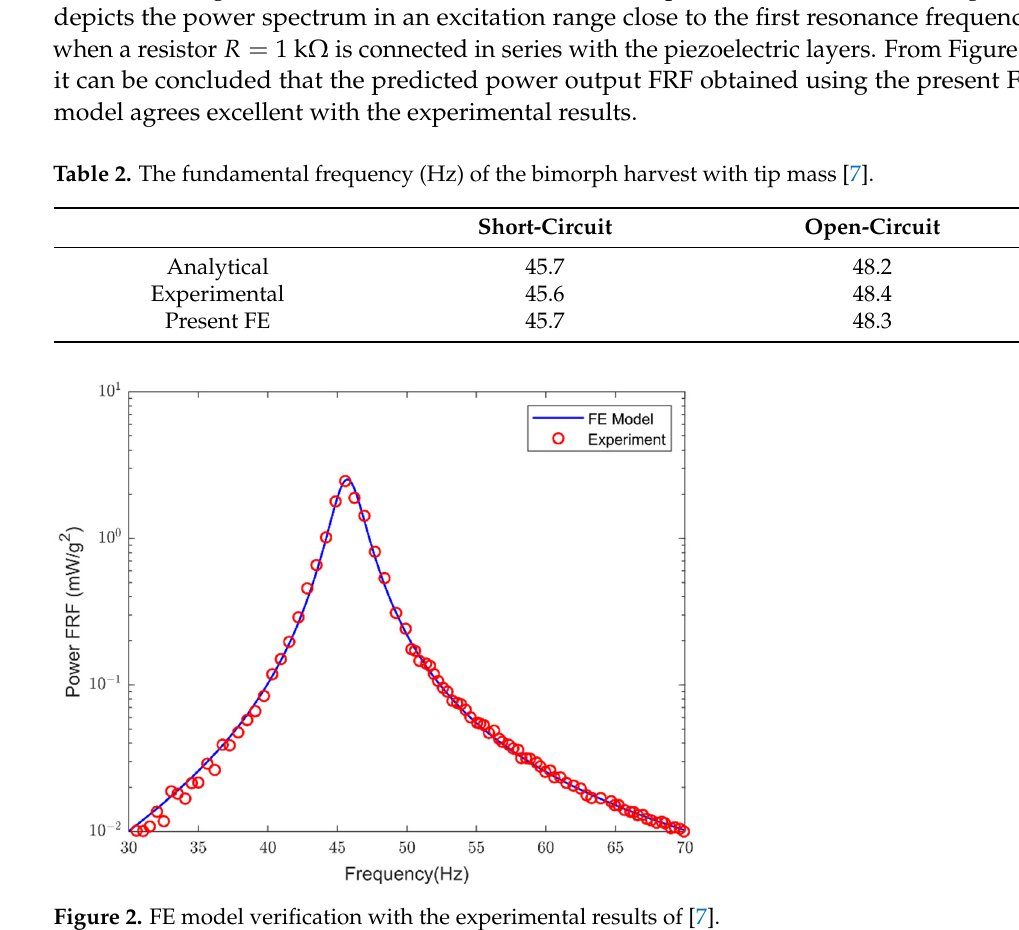
Figure 2. FE model verification with the experimental results of [7].